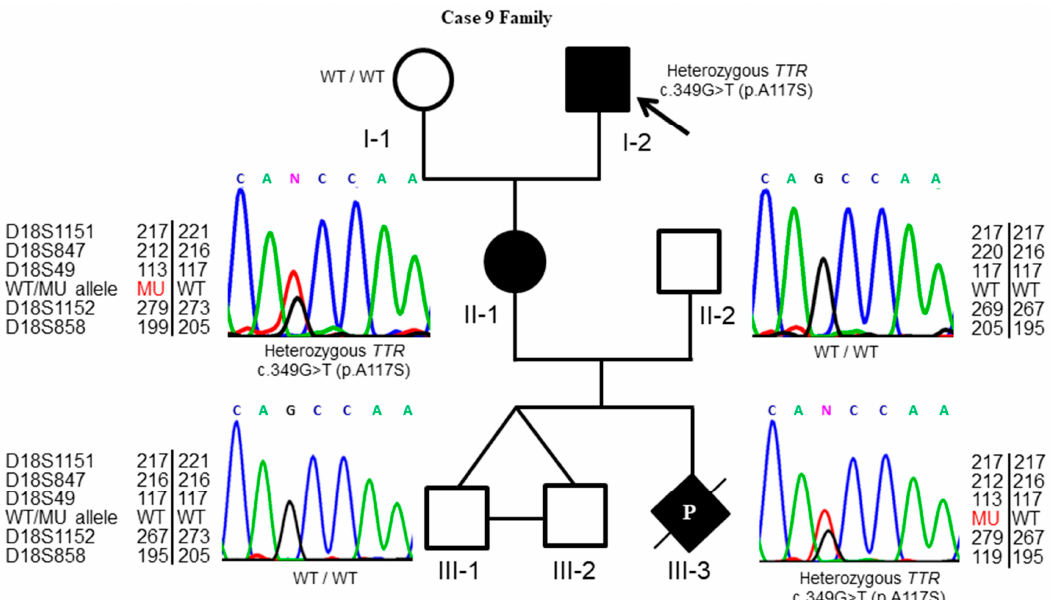
Figure 2. Pedigree and TTR genotyping of an index family with FAP. Case II-1 (i.e., Case 9 in Table 3), carrying a familial c.349G > T (p.A117S) mutation, adopted PGD and a triplet pregnancy was achieved after transferring two una ff ected embryos. Prenatal diagnosis by direct sequencing and linkage analysis with give informative microsatellite markers (D18S1151, D18S847, D18S49, D18S1152, and D18S858) revealed una ff ected identical twins (III-1 and III-2) and one a ff ected singleton (III-3), indicating the occurrence of ADO in PGD. Filled and open symbols represent a ff ected and una ff ected individuals, respectively; circles, squares, and diamonds indicate females, males and individuals of unknown sex, respectively; P with a diagonal line indicates selective fetal reduction during the pregnancy. The arrow indicates the a ff ected proband (I-2). C, A, G, N indicated the cytosine, adenine, guanine and ambiguous base calling respectively in the DNA sequence.